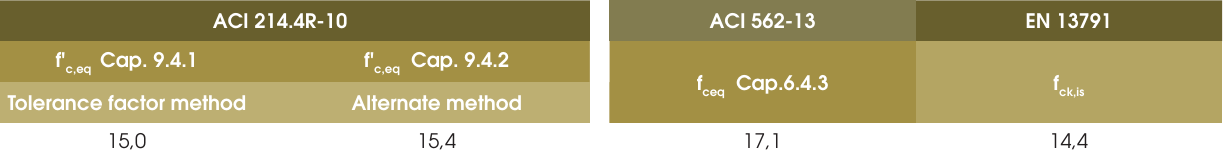
Table 8 – Values for f proposed by standards ACI 214.4R-10, ACI 562-13 and EN c,equivalent